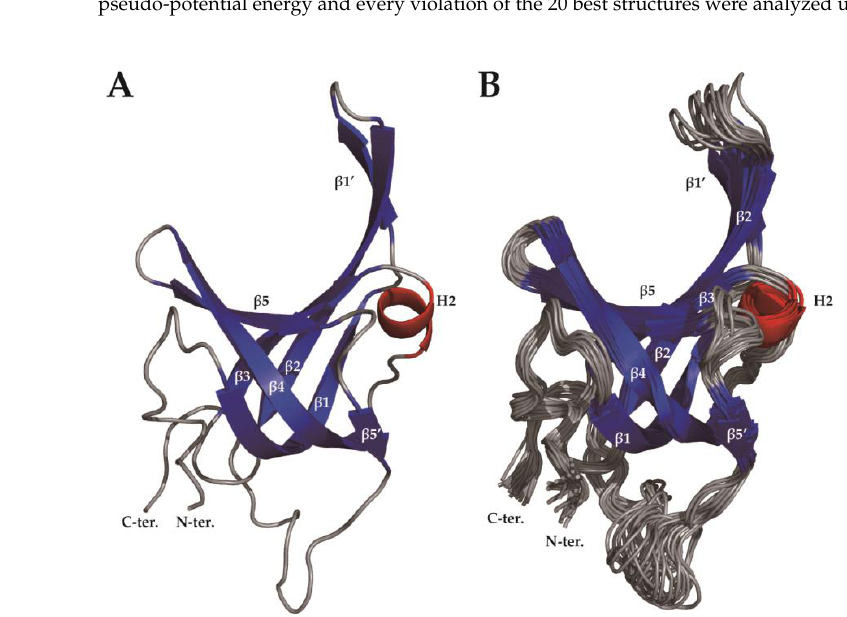
Figure 3. ( A ) The averaged 20 lowest energy solution structures of SsoSSB 1 – 114 . ( B ) Ensemble of the 20 lowest energy solution structures of SsoSSB 1 – 114 . The 3 10 helix is indicated in red, and β strands are shown in blue.